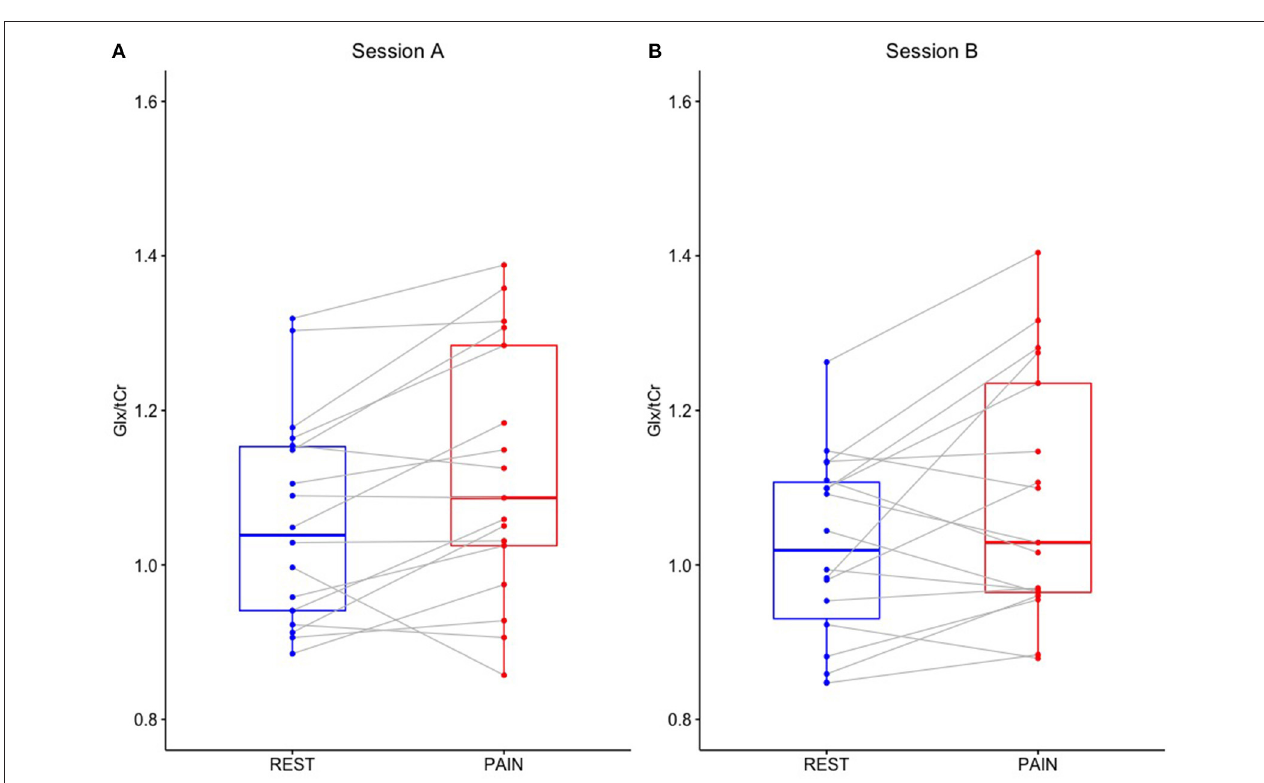
FIGURE 4 | Glx/tCr in the dACC (ROI-2) during REST and PAIN conditions for scanning sessions (A,B)